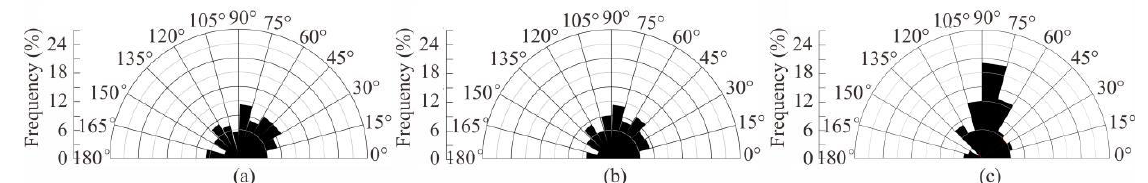
Figure 17. The histogram of the grained rose in the CT scan of glacial till. ( a ) X–section particles long axis direction. ( b ) Y–section particles long axis direction. ( c ) Z–section particles long axis direction.